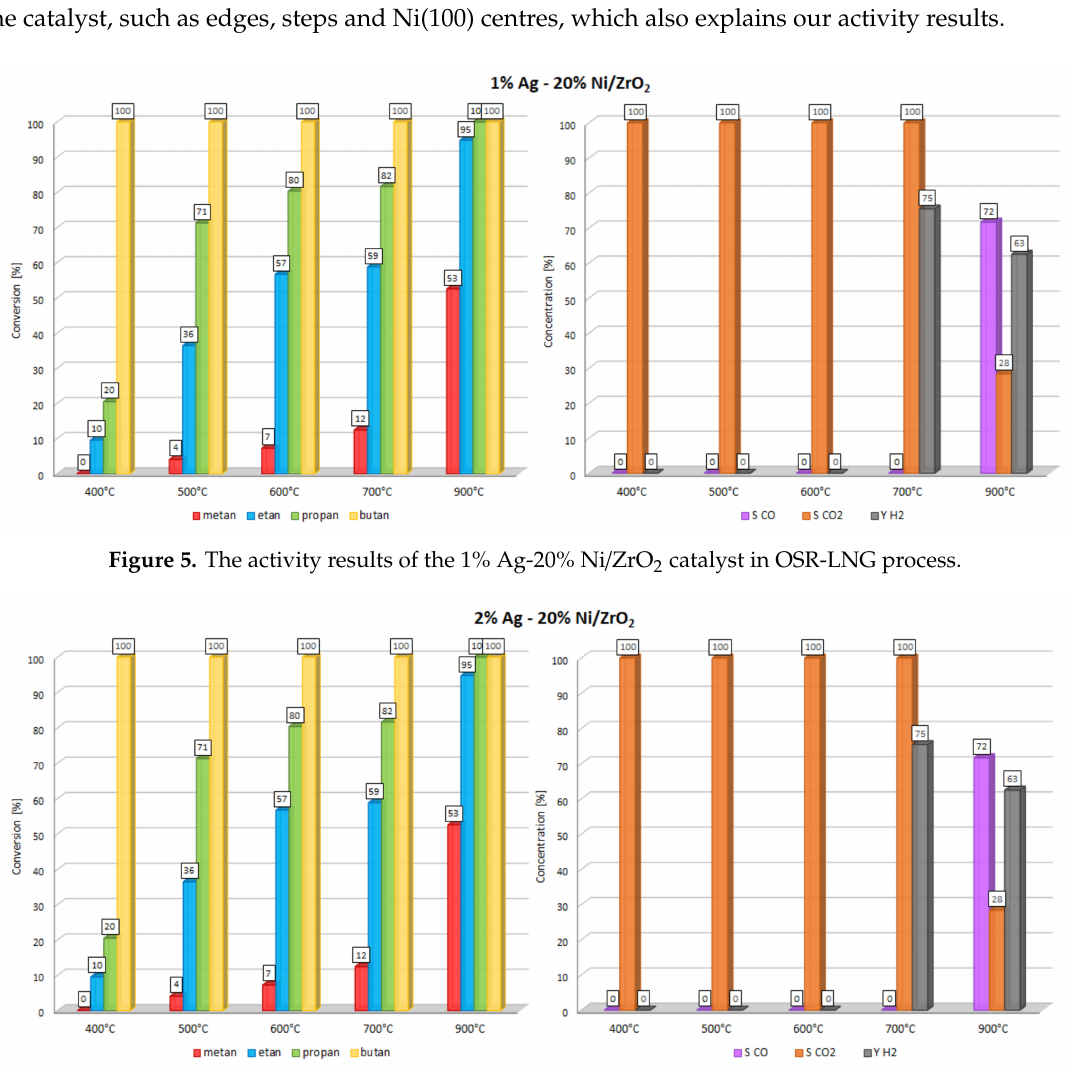
Figure 6. The activity results of the 2% Ag-20% Ni / ZrO 2 catalyst in OSR-LNG